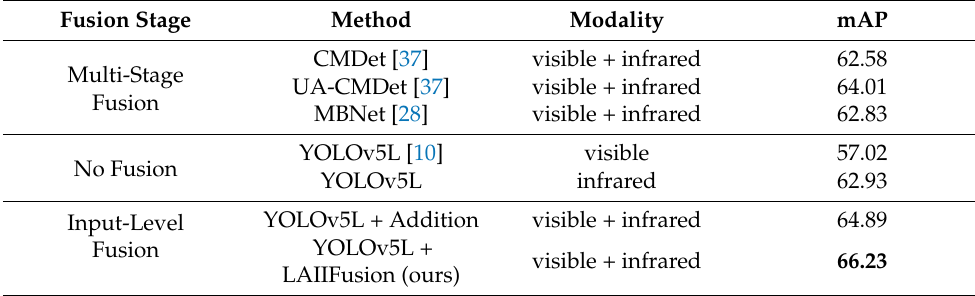
Table 1. Comparisons of detection performance on the DroneVehicle dataset.